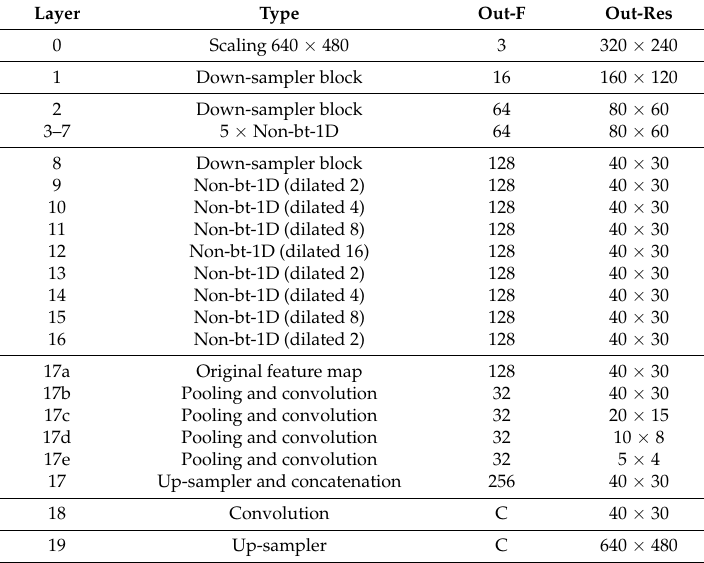
Table 1. Layer disposal of our proposed network. “Out-F”: Number of Feature maps at the layer’s “C”: number of semantic prediction Classes. Encoder: Layers 1–16, decoder: Layers